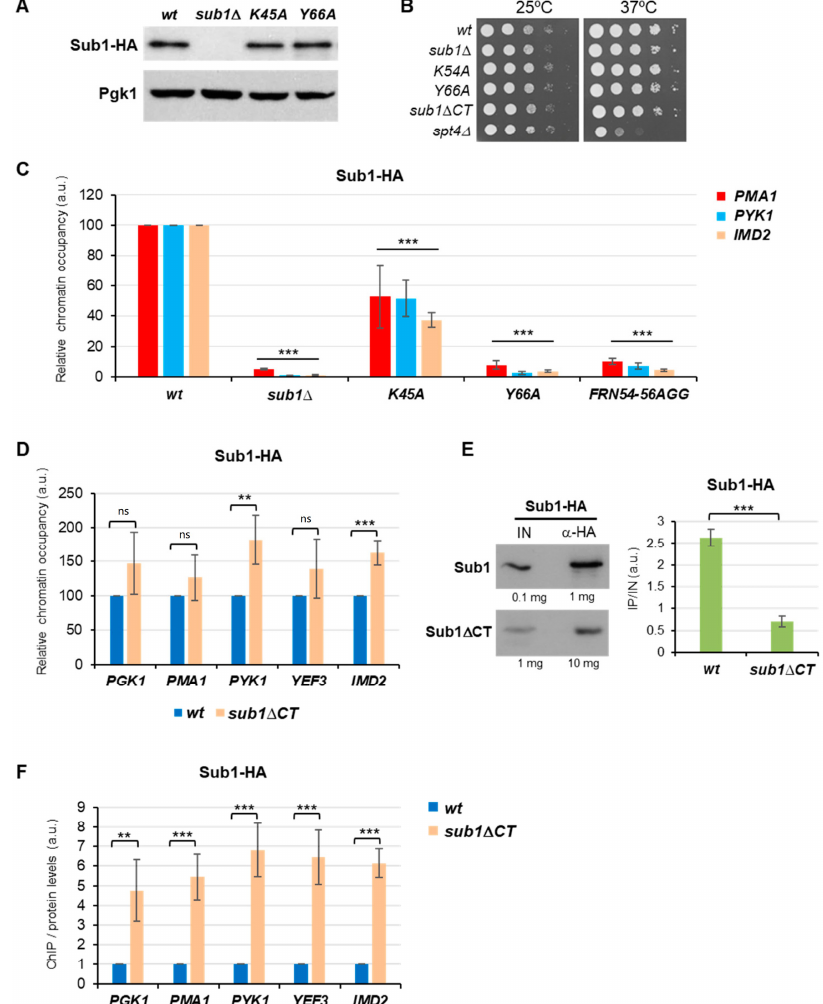
Figure 2. Evolutionarily conserved residues of ScSub1 ssDBD are crucial for its DNA binding capacity in vivo. ( A ) Analysis of Sub1-6HA levels in wt (Sub1-6HA), sub1 ∆ , and ssDBD mutants ( sub1-K45A , sub1-Y66A ) cells by Western blot. Levels of Pgk1 were used as a control of loaded proteins. ( B ) Yeast strains with the indicated genotypes were spotted onto solid media plates (1:10 serial dilutions) and grown at 28 ◦ C or 37 ◦ C for 2–3 days. spt4 ∆ cells were used as a control for cell growth and thermo-sensitivity defects. ( C ) ChIP analyses of Sub1-HA in the wt , sub1 ∆ , and ssDBD mutants ( sub1- K45A , sub1-Y66A and sub1-FRN54-56AGG ). Sub1 occupancy at the 5 (cid:48) region of two constitutively expressed genes, PMA1 and PYK1, and the induced gene, IMD2, were examined by qPCR, and quantifications were graphed (see Materials and Methods). The numbers on the Y-axis represent the occupancy of Sub1 at the promoters in mutant cells relative to wt cells, in which occupancy is considered 100%. ( E ) ChIP analysis of wt and sub1 ∆ CT cells expressing Sub1-6HA, as in ( D ). In this case, four constitutively transcribed genes were examined: PGK1, PMA1, PYK1, and YEF3, as well as IMD2 . ( E ) Left: co-immunoprecipitation assays (Co IP) to estimate Sub1-HA levels in wt and sub1 ∆ CT cells; whole cell extracts (WCE) were prepared from strains expressing Sub1-6HA, and either 1 mg or 10 mg of WCE were used to immunoprecipitate Sub1 from wt or sub1 ∆ CT cells, respectively. Immunoprecipitated ( α -HA) or inputs (IN)—0.1 mg and 1 mg, respectively—were loaded onto a 12% SDS-PAGE gel and immunoblotted with anti-HA. Right: chemiluminescence of immunoreactive bands from Western blots were quantified and graphed. ( F ) Ratio ChIP/protein levels with values obtained in D and E, respectively. In all cases, the mean and standard deviation values were calculated from at least three independent experiments. Statistically significant levels are shown where ns = non-significant, ** = p < 0.01, *** = p <